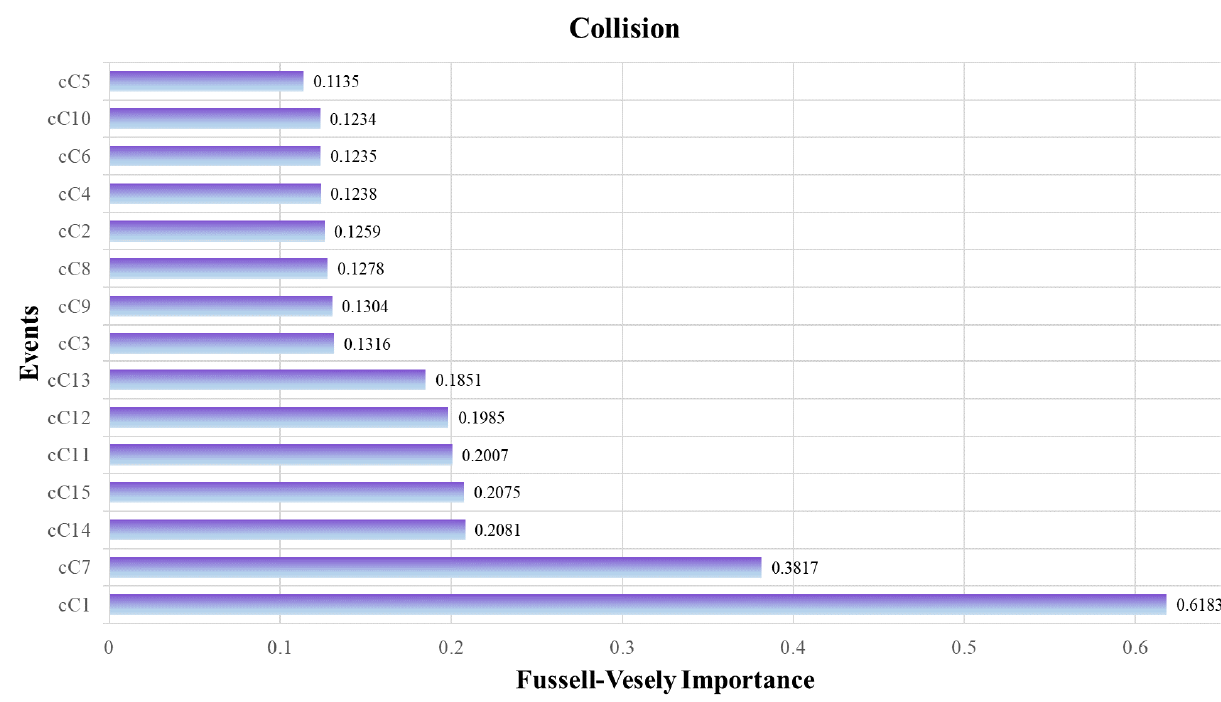
Figure 16. Fussell–Vesely Importance of each basic event of a collision accident.